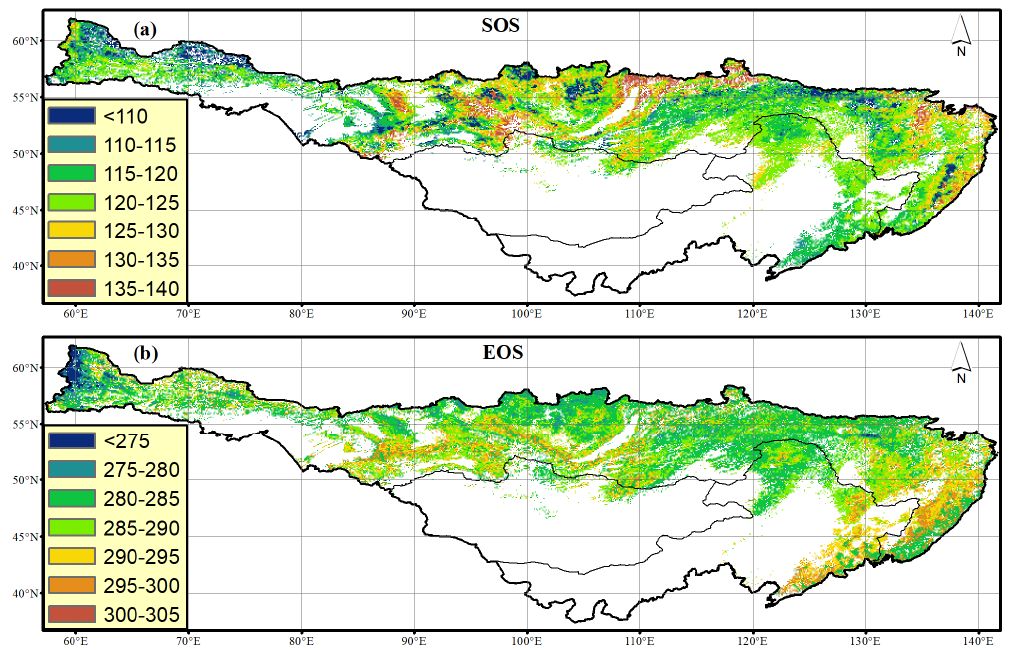
Table 1. The mean and standard deviation of start date (SOS) and the end date (EOS) of the growing season for different forests types.